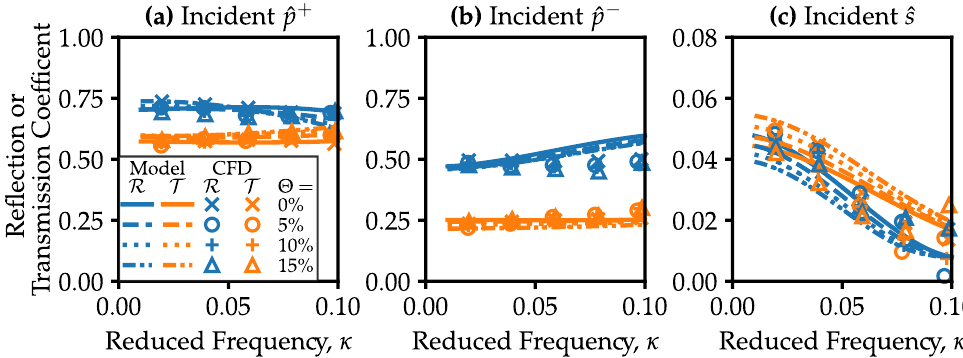
Figure 5. Reflection and transmission coefficients for a cooled vane cascade, with varying coolant flow rates Θ , predicted by cambered analytical model and CFD. The change in pressure wave reflection coefficients is small: within 3% of the mean value over all flow rates. ±